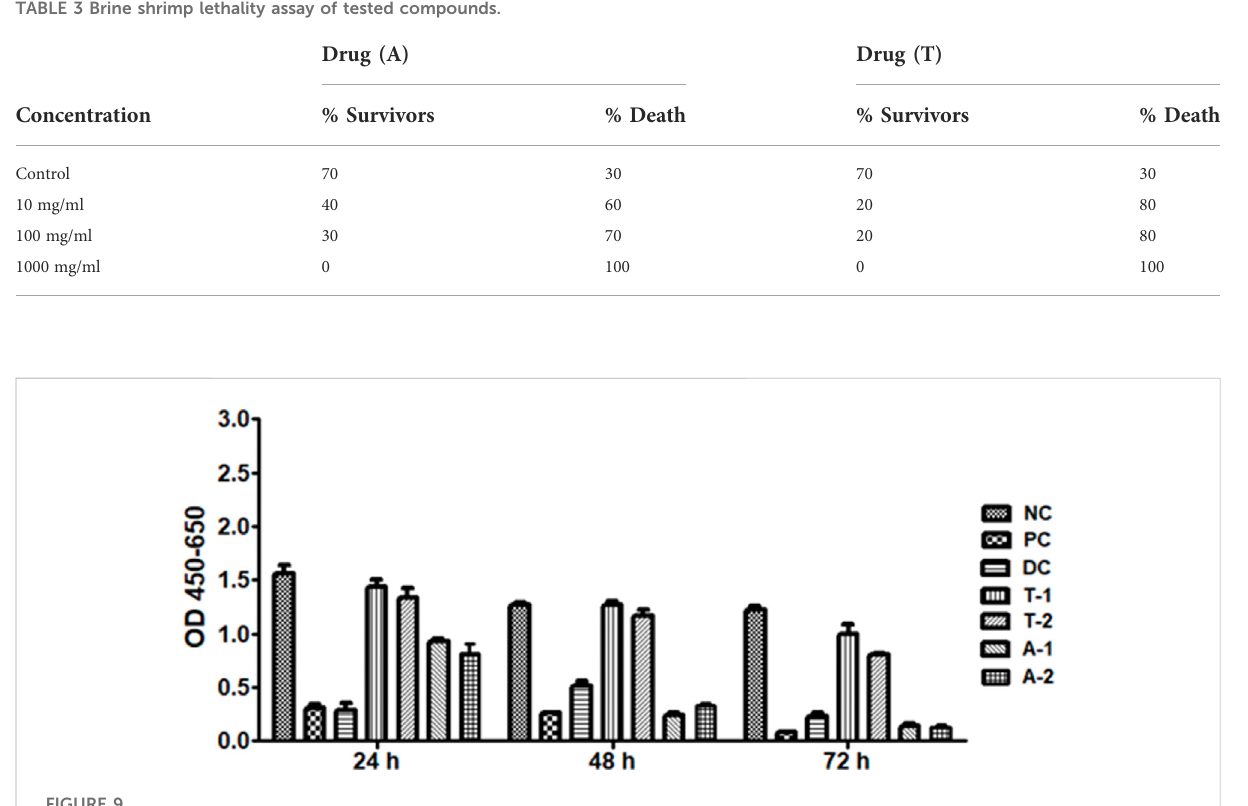
FIGURE 9 Cytotoxic analysis of the drugs adapalene (A1 and A2) and tamsulosin (T1 and T2) against HepG2 cell lines. The graph shows potential inhibition of proliferation of cells after 72 h of treatment. Graphical data are presented as mean ±